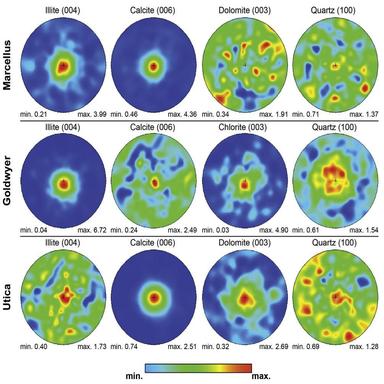
Results from bulk neutron diffraction analysis showing basal pole figures of illite, calcite, chlorite, dolomite and quartz for the three measured shale samples. Pole figures are coloured according to intensity changing from minimum value (blue) to maximum value (red) given for each pole figure in m.r.d. Projection is on the bedding plane. (For interpretation of the references to colour in this figure legend, the reader is referred to the Web version of this article.)